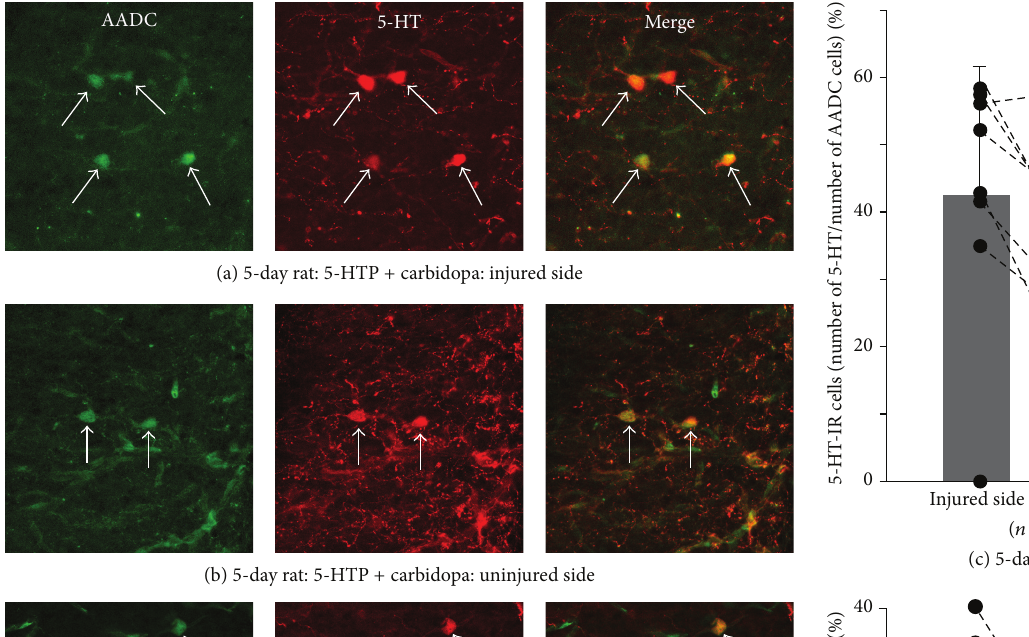
in the two time groups treated with 5-HTP and